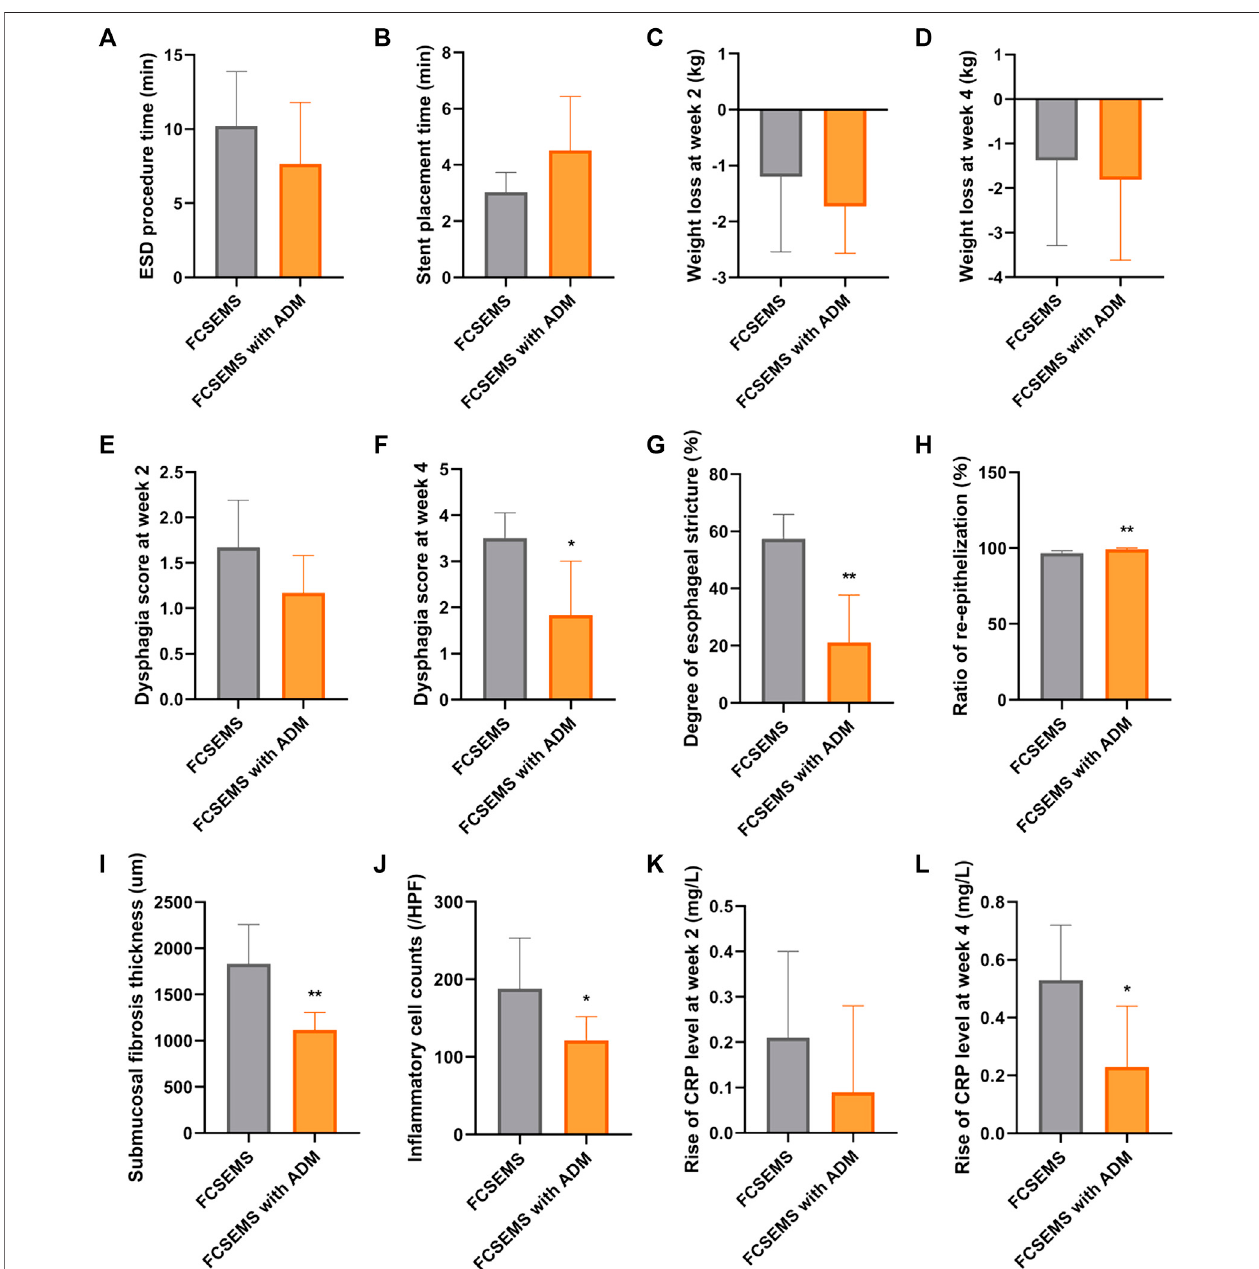
FIGURE 4 | Data comparisons between the ADM-FCSEMS group (A) and FCSEMS group (B) . Comparisons of the (A) ESD procedure time, (B) stent placement time, (C) weight loss at week 2 post-ESD, (D) weight loss at week 4 post-ESD, (E) dysphagia score at week 2 post-ESD, (F) dysphagia score at week 4 post-ESD, (G) stricture degree in the macroscopic evaluation, (H) ratio of re-epithelization, (I) submucosal fi brosis thickness, (J) in fl ammatory cell counts, (K) rise of C-reactive protein (CRP) level at week 2 post-ESD, and (L) rise of CRP level at week 4 between both groups. Bars with an asterisk are indicating signi fi cant differences [ p < 0.05 ( p ), p < 0.01 ( pp